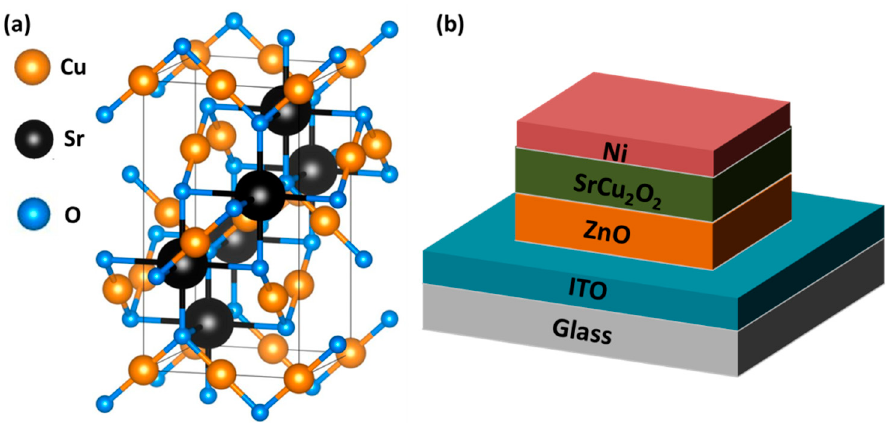
Figure 6. ( a ) Crystal structure of SrCu 2 O 2 ; ( b ) Schematic drawing of a typical p-n junction by ZnO/SrCu 2 O 2 .